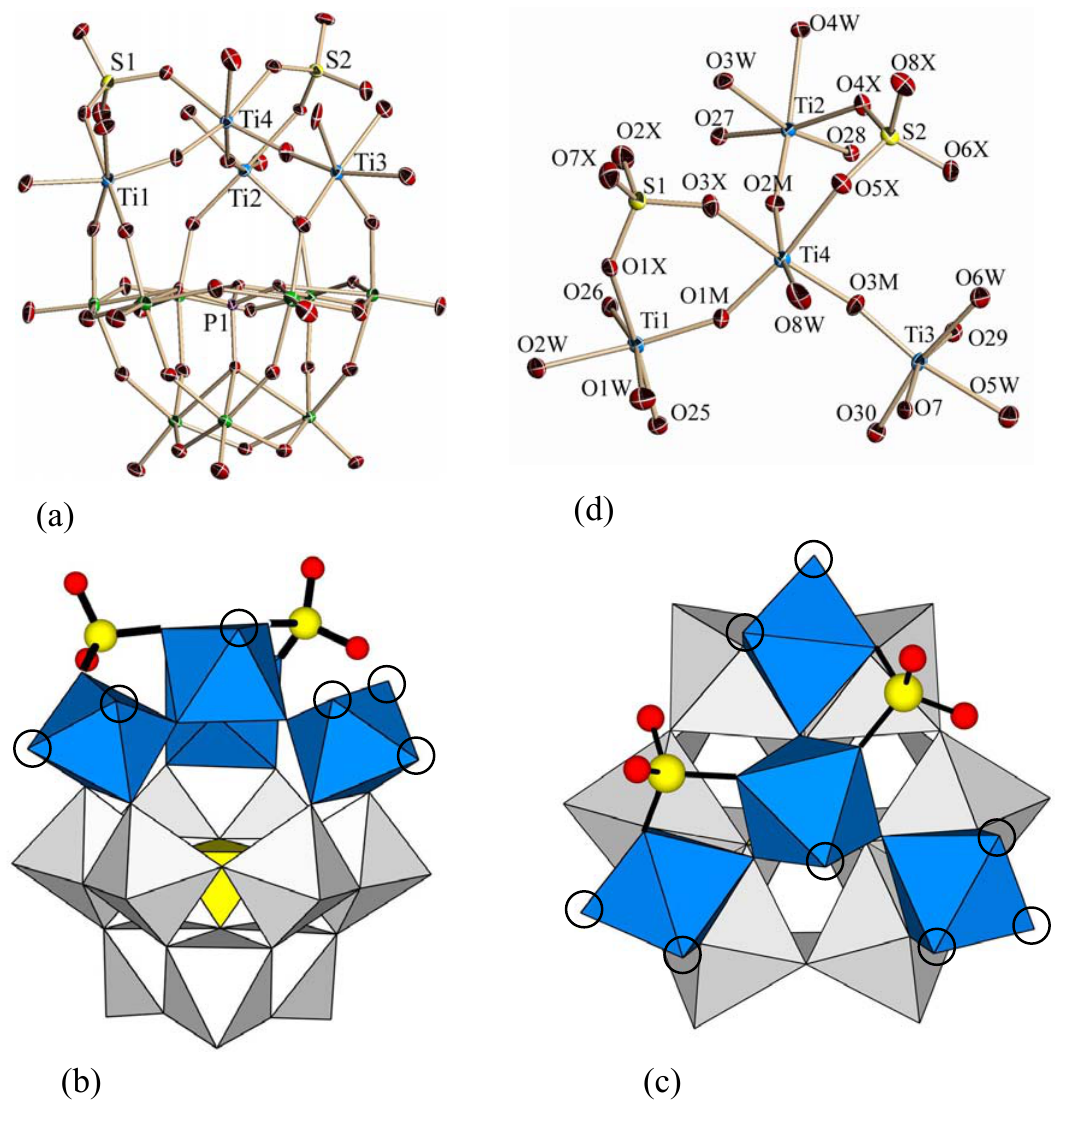
Figure 3. (a) Molecular structure of the monomeric polyoxoanion [{Ti O) (SO ) (H O) }( α -PW O )] 3- ( 2 ) in K-2 , polyhedral representations ((b) side view and 3 4 2 2 8 9 34 (c) top view), and (d) the partial structure around the Ti octahedral TiO units are shown in blue, all nine WO 6 group is shown in yellow. The two sulfate ions coordinated to titanium(IV) one central PO 4 octahedra are shown as yellow circles (S) and red circles (O), and the coordinated water molecules to titanium(IV) octahedra are exhibited by open